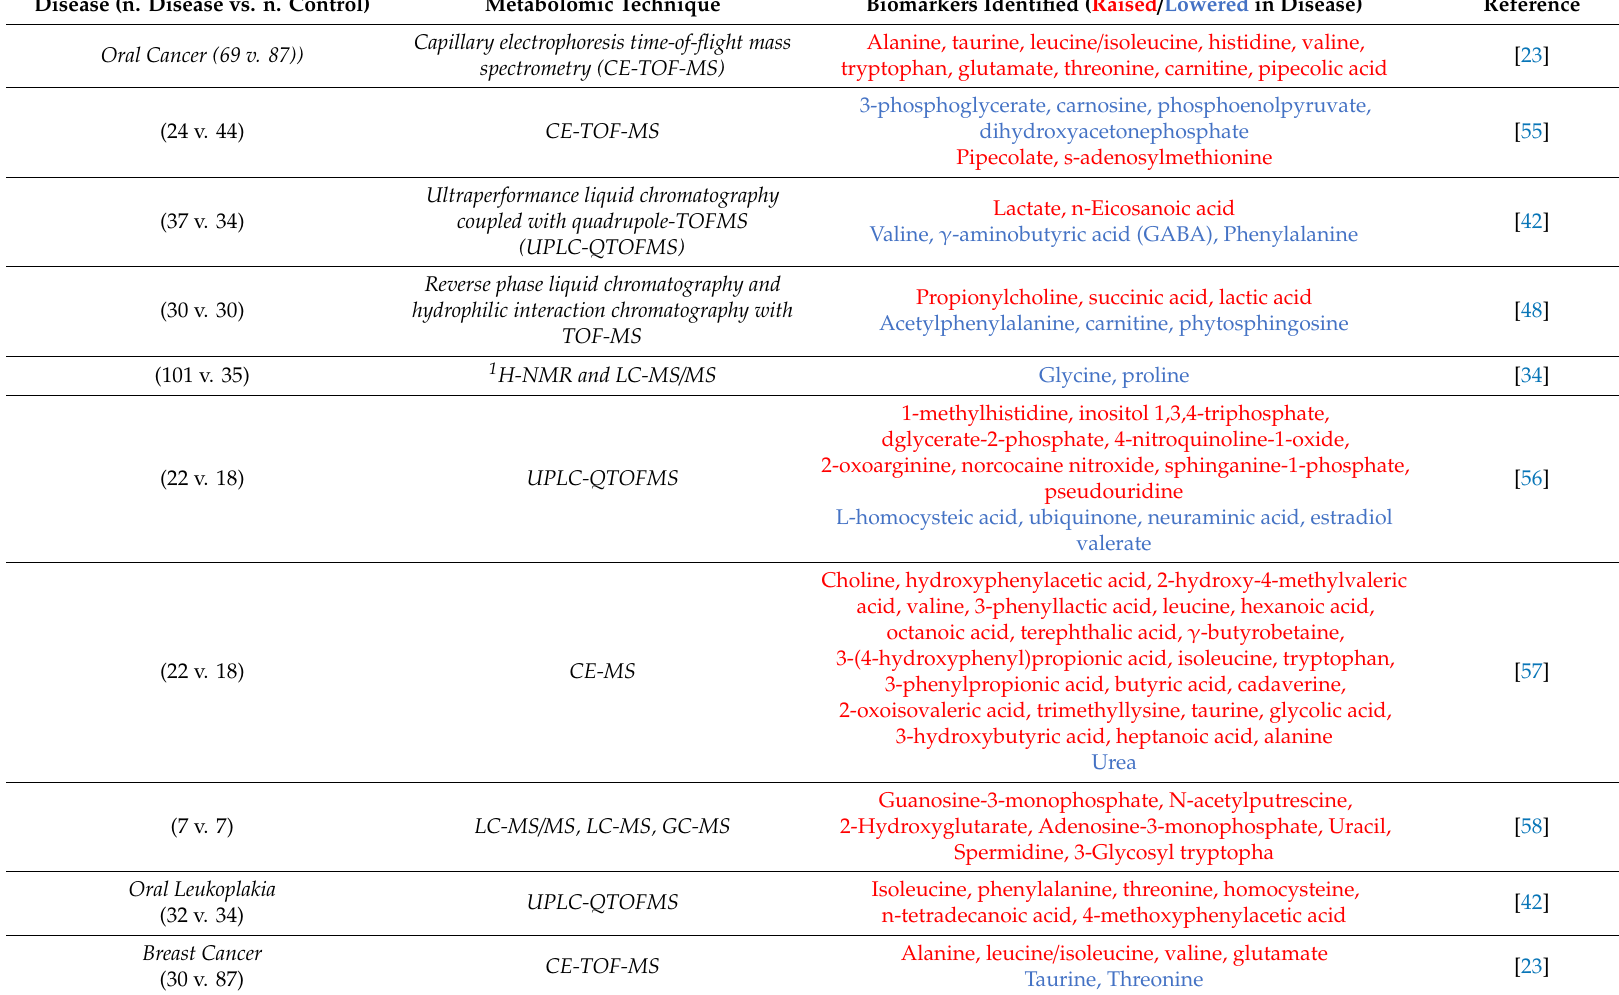
Table 1. A summary of studies investigating the potential of salivary metabolomics in biomarker discovery. Disease (n. Disease vs. n.